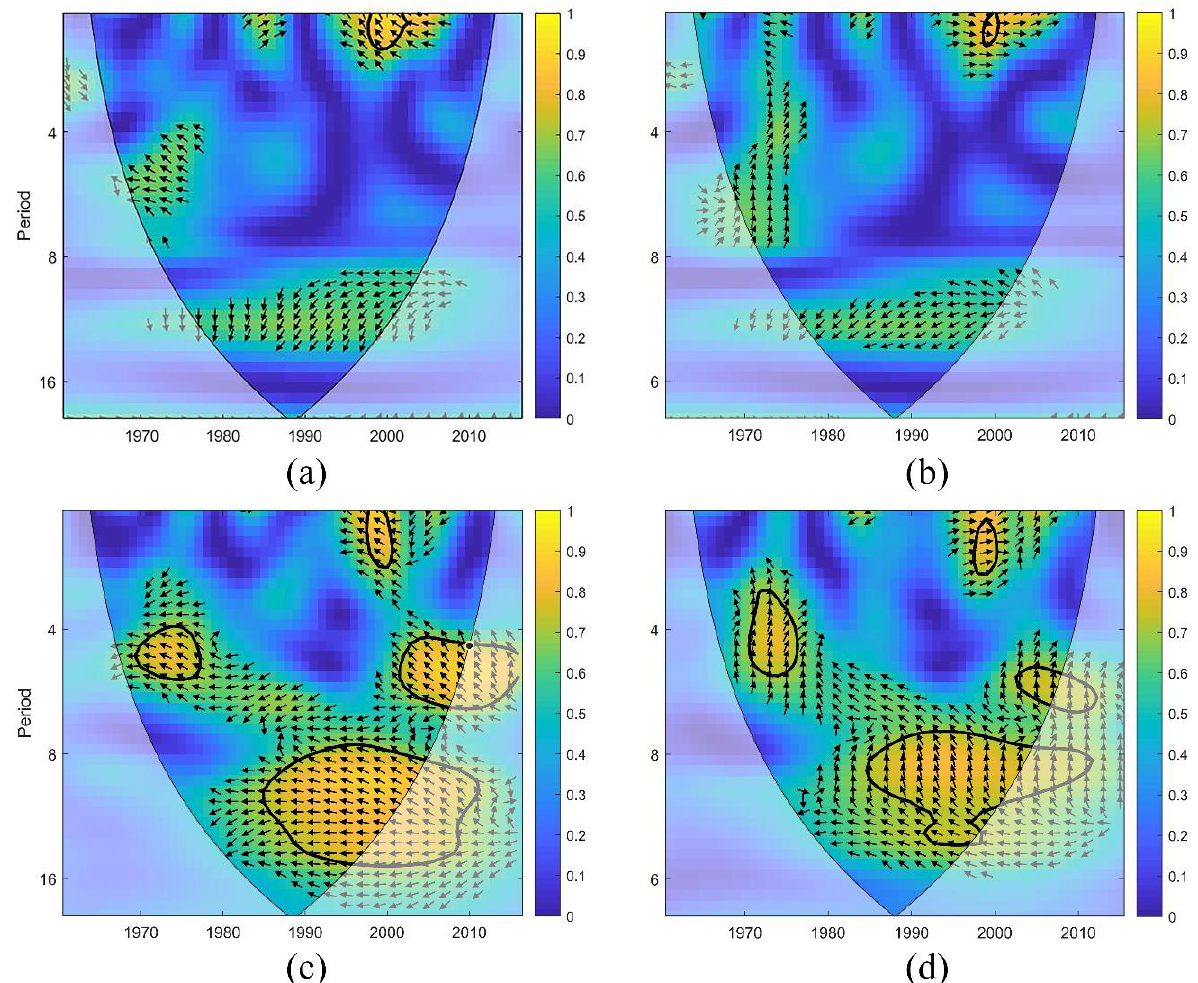
Figure 4. Differences between the streamflow anomalies and ENSO indices (first row) as well as IOD indices (second row) were obtained using the WTC method. ( a , c ) Developing years, ( b , d ) Decaying years. Areas enclosed by thick lines represent statistically significant coherence at a 5% significance level concerning noise (yellow) based on the Monte Carlo simulation method. Arrows indicate wavelet coherences above 0.5, which represent the phase difference of the oscillations. The arrows pointing right show in-phase coherence, whereas those pointing left show anti-phase coherence.